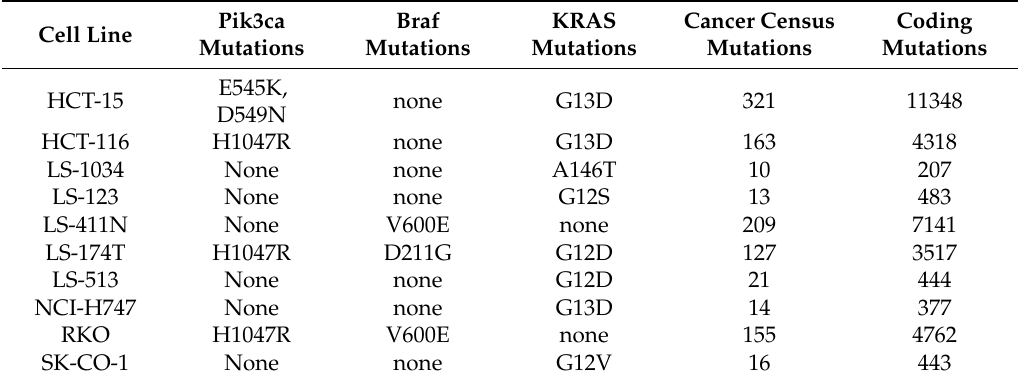
Table 2. CRC cell lines studied in this report and their